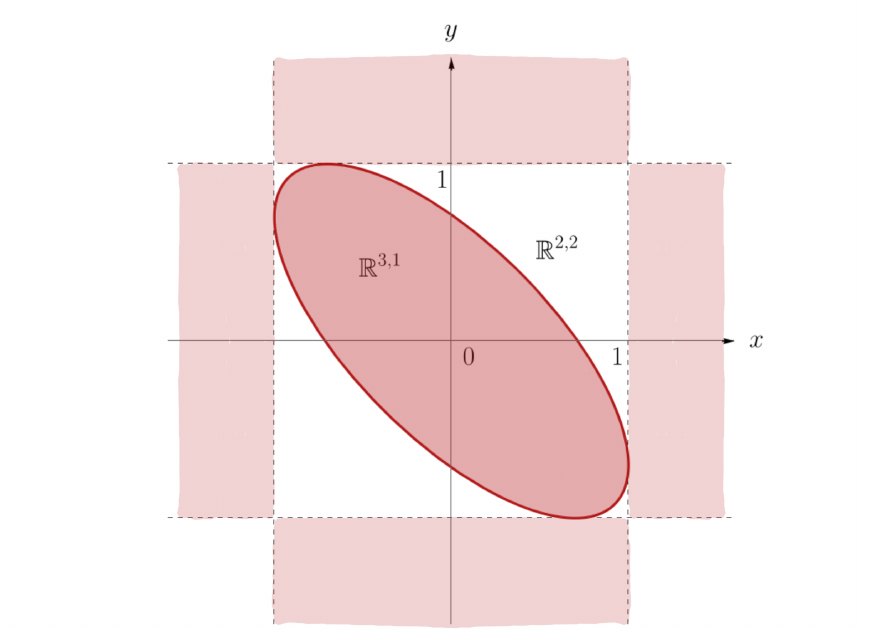
Figure 12 . The dark shaded represents the region inside the R 3 , 1 elipse and the light shaded represents the type IId region, where, ¯ z is negative and z is